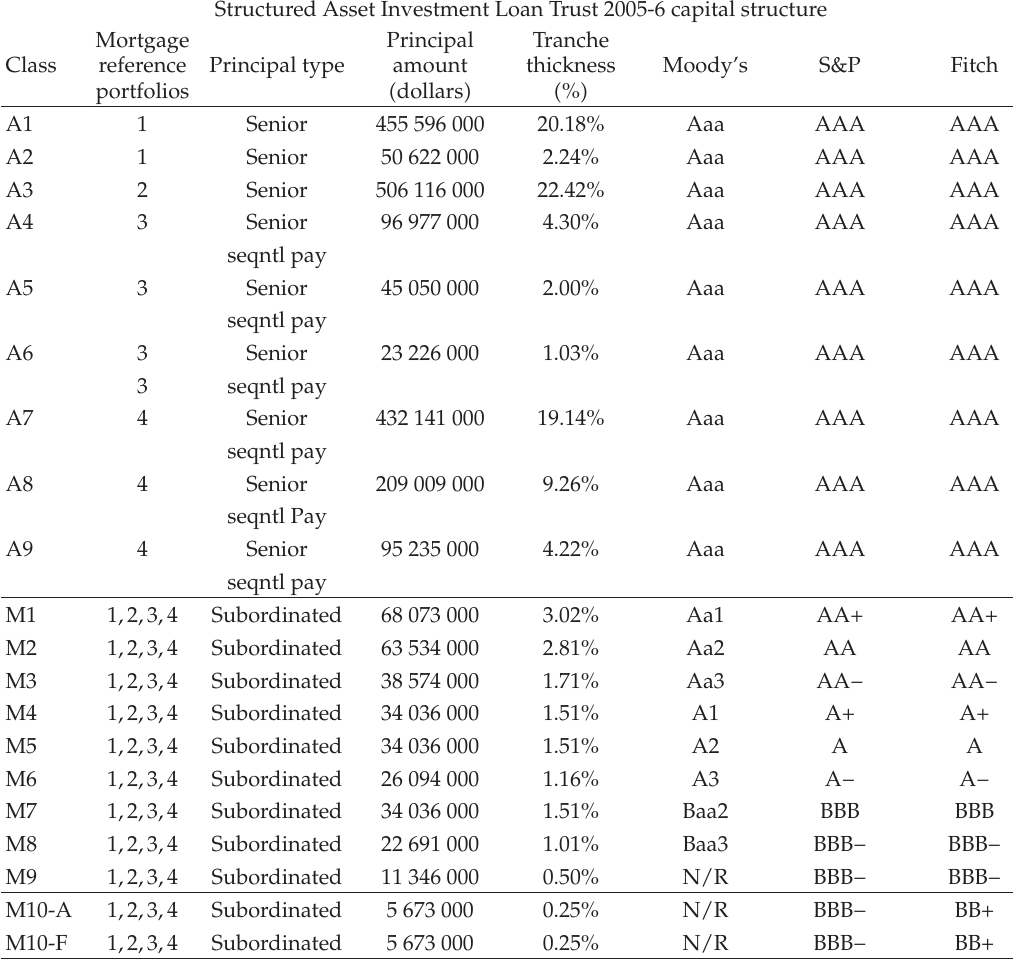
Table 6: Structured Asset Investment Loan Trust 2005-6 capital structure; source: (cid:6) 25 (cid:7) . Structured Asset Investment Loan Trust 2005-6 capital